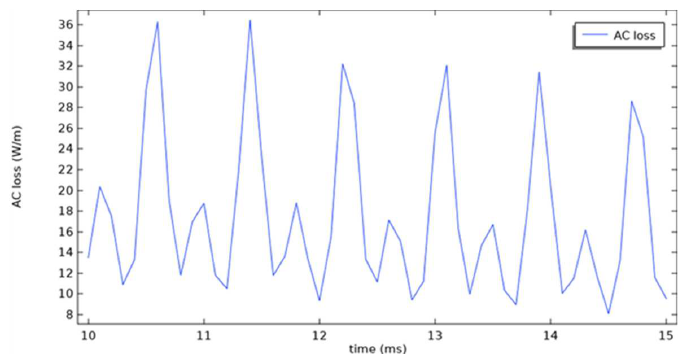
Figure 10. J / J c ( B ) distribution in the coil model.